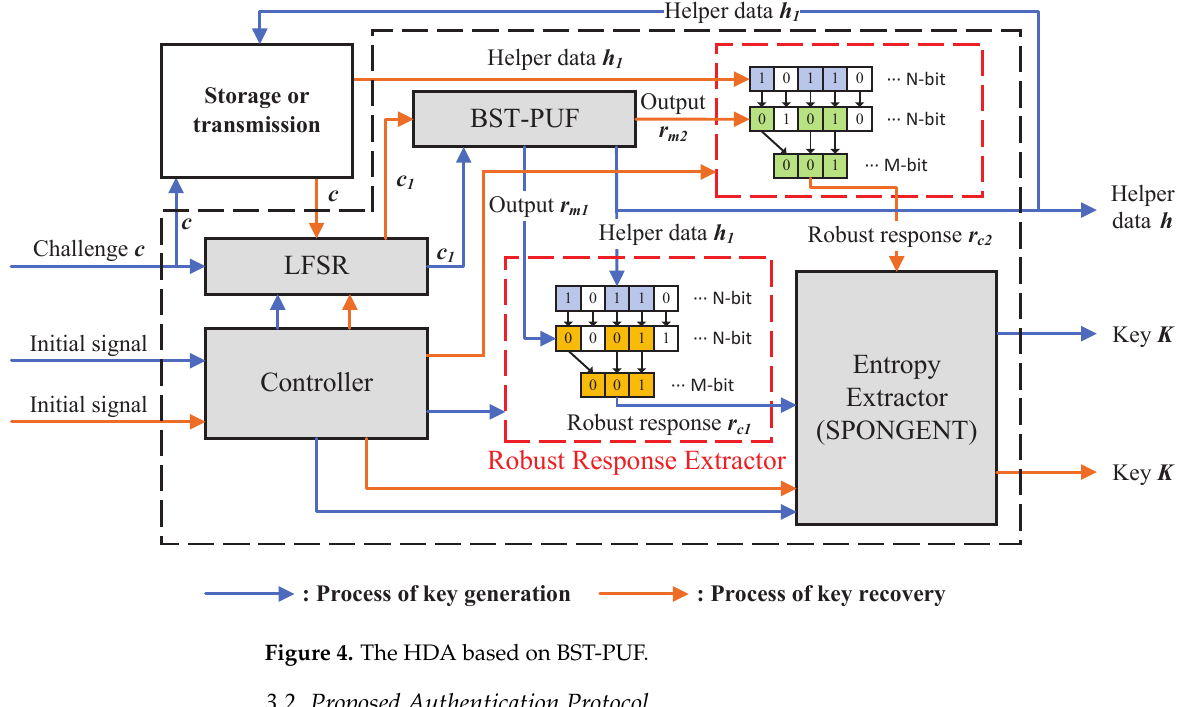
Figure 4. The HDA based on